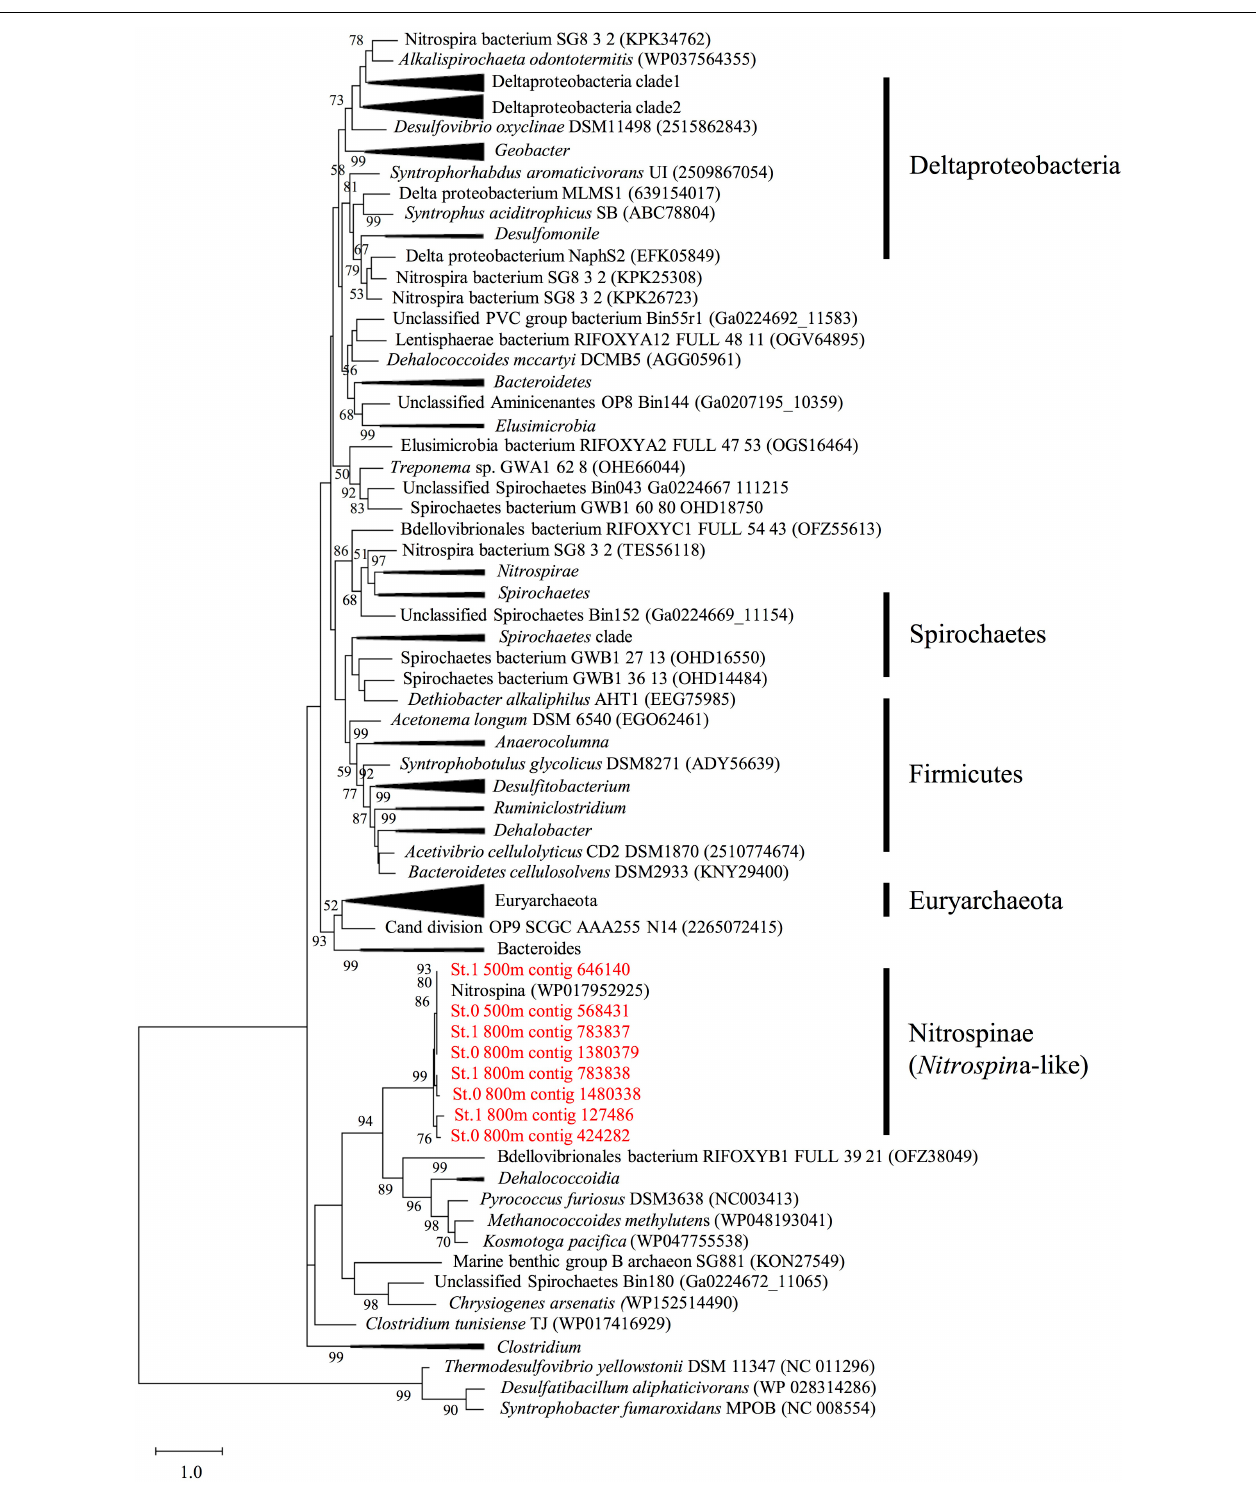
FIGURE 5 | Maximum likelihood phylogenetic tree of the hgcA sequences identified in the assembled contigs obtained from mesopelagic layers (depths of 500 and 800 m) at Stations 0 and 1 in the East China Sea. The sequences identified in this study (shown in red) were compared with the hgcA homologs described in previous studies (Gilmour et al., 2013, 2018; Gionfriddo et al., 2016; Christensen et al., 2019; Jones et al., 2019). The tree is rooted on hgcA paralogs from non-methylators. Bootstrap values > 50 are shown, with consensus based on 100 replicates. The National Center for Biotechnology Information accession numbers or Integrated Microbial Genomes predicted gene numbers are